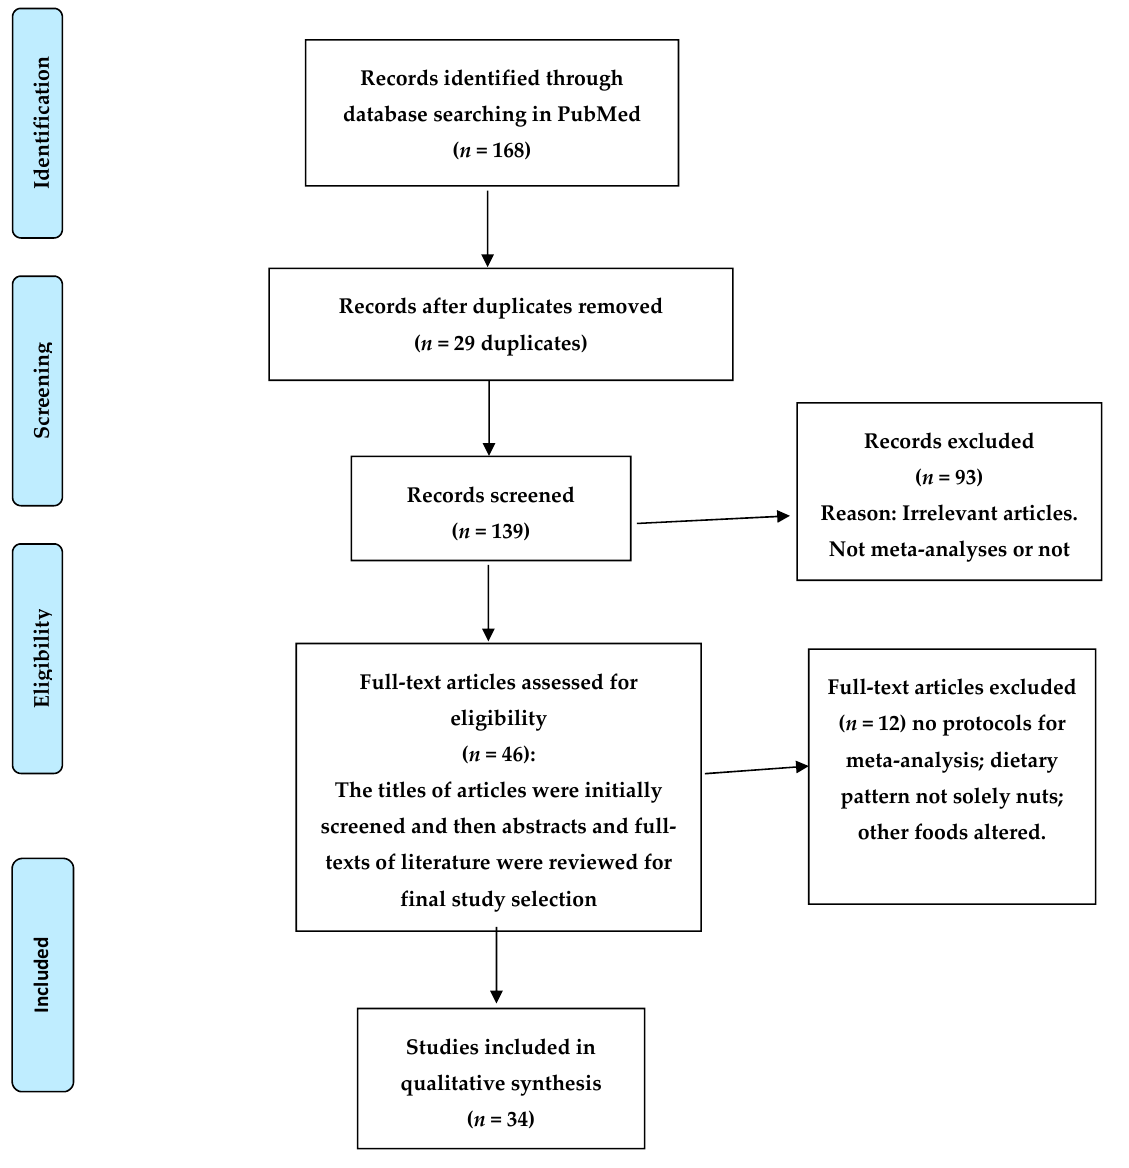
Figure 1. Flow diagram of the literature review.